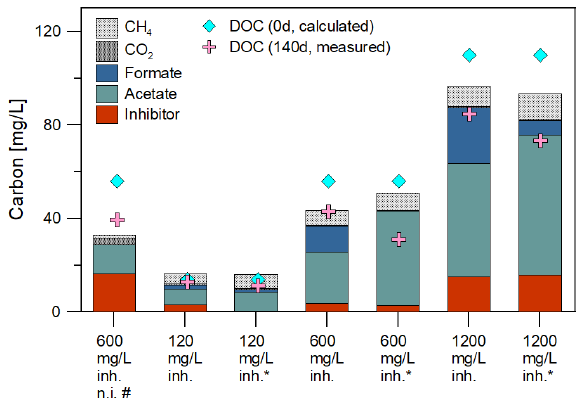
Figure 2. Initial DOC concentration and carbon balance after 140d of degradation: The initial DOC concentration was calculated with the carbon content of the fluid and the inhibitor. The main degradation products identified were acetate, formate, methane and CO 2 . The mass balance confirmed the almost complete conver- sion of the polycarboxylate inhibitor in inoculated batches. Sam- ples marked with asterisk (*) were inoculated with the 120mg/L inhibitor preculture. Others were inoculated with 1200mg/L precul- ture. The sample marked with (#) was without an inoculated steel